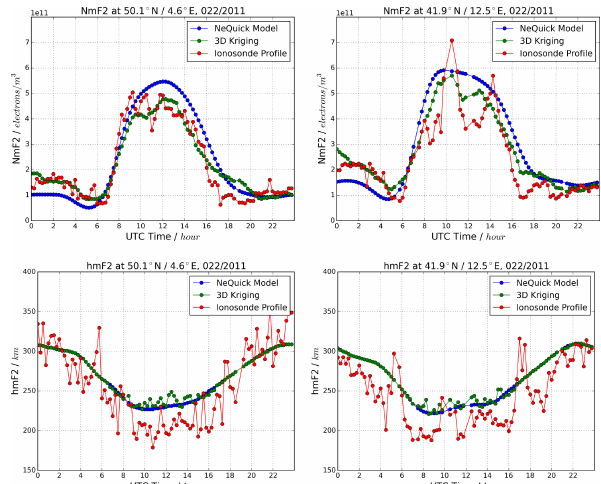
Figure 5. Comparison of the NeQuick electron density profile (blue), the reconstructed electron density profile (green) and the ionosonde profile (red) of the ionosonde station DB049 on DOY 22 (2011) at 02:00, 12:00, 13:30 and 16:00UTC.